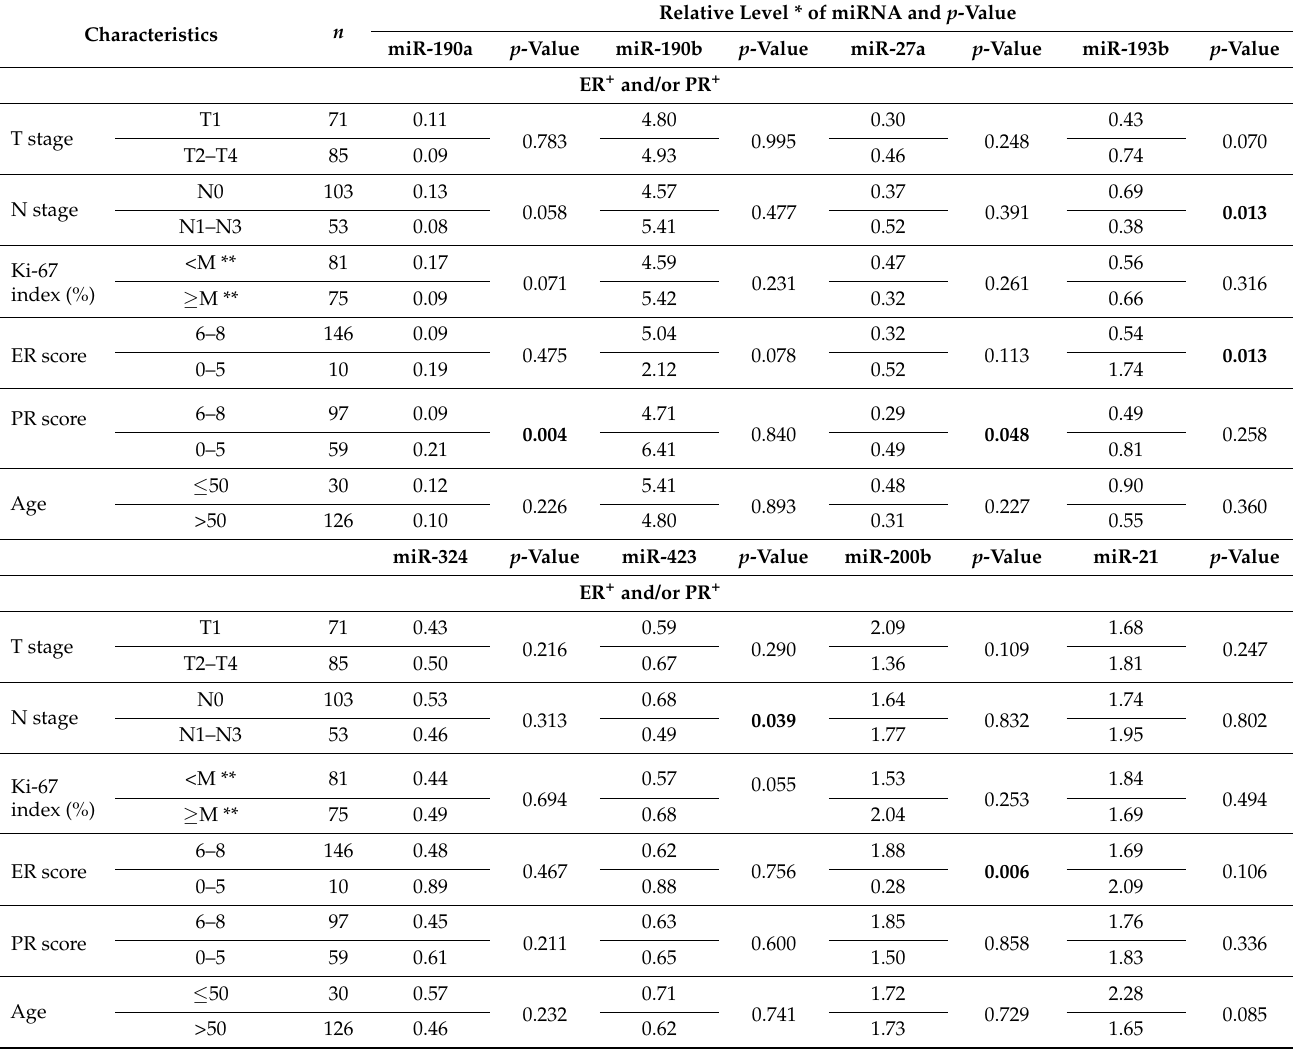
* Median of relative differences in miRNA amounts between breast tumors and paired samples of normal adjoining (control) tissue; the results were normalized to the control. ** M—median value. For ER- and/or PR-positive BC, median = 18. Significant differences are highlighted in